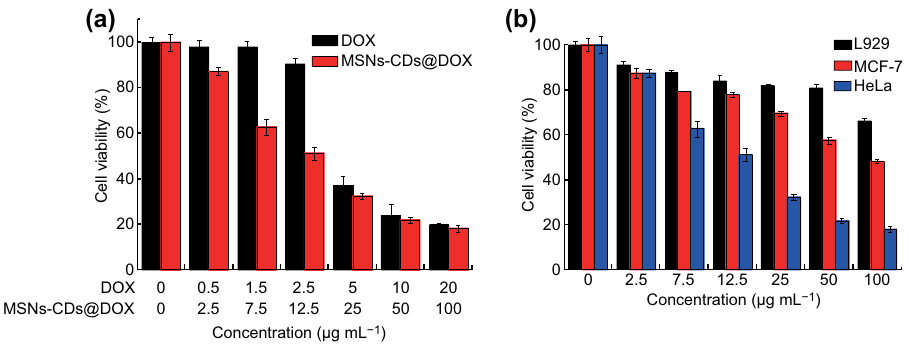
Fig. 6 a Therapeutic efficacy of MSNs–CDs@DOX and equivalent concentrations of free DOX against HeLa cells at different concentrations. b Therapeutic efficacy of MSNs–CDs@DOX against L929, MCF-7, and HeLa cells at different